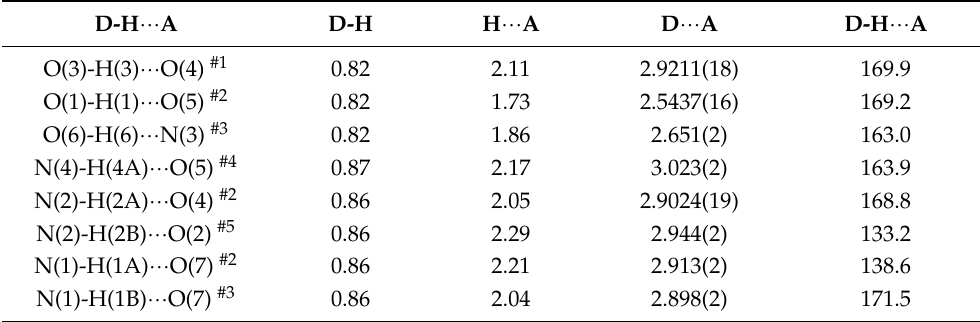
Figure 3. ( a ) Asymmetric unit of the MTF–CIT molecular salt. ( b ) fragment of the H-bonded CIT- chain that extends along the a axis. ( c ) View of the sheet structure built by CIT - anions. Table 2. Hydrogen bonds for MTF-CIT (Å and °).